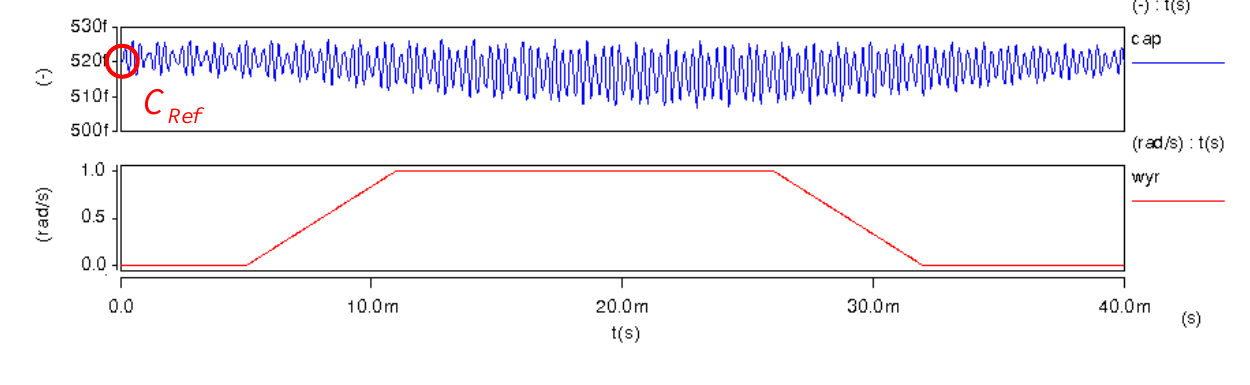
Figure 12. Using the ARCHITECT TM simulator to solve C